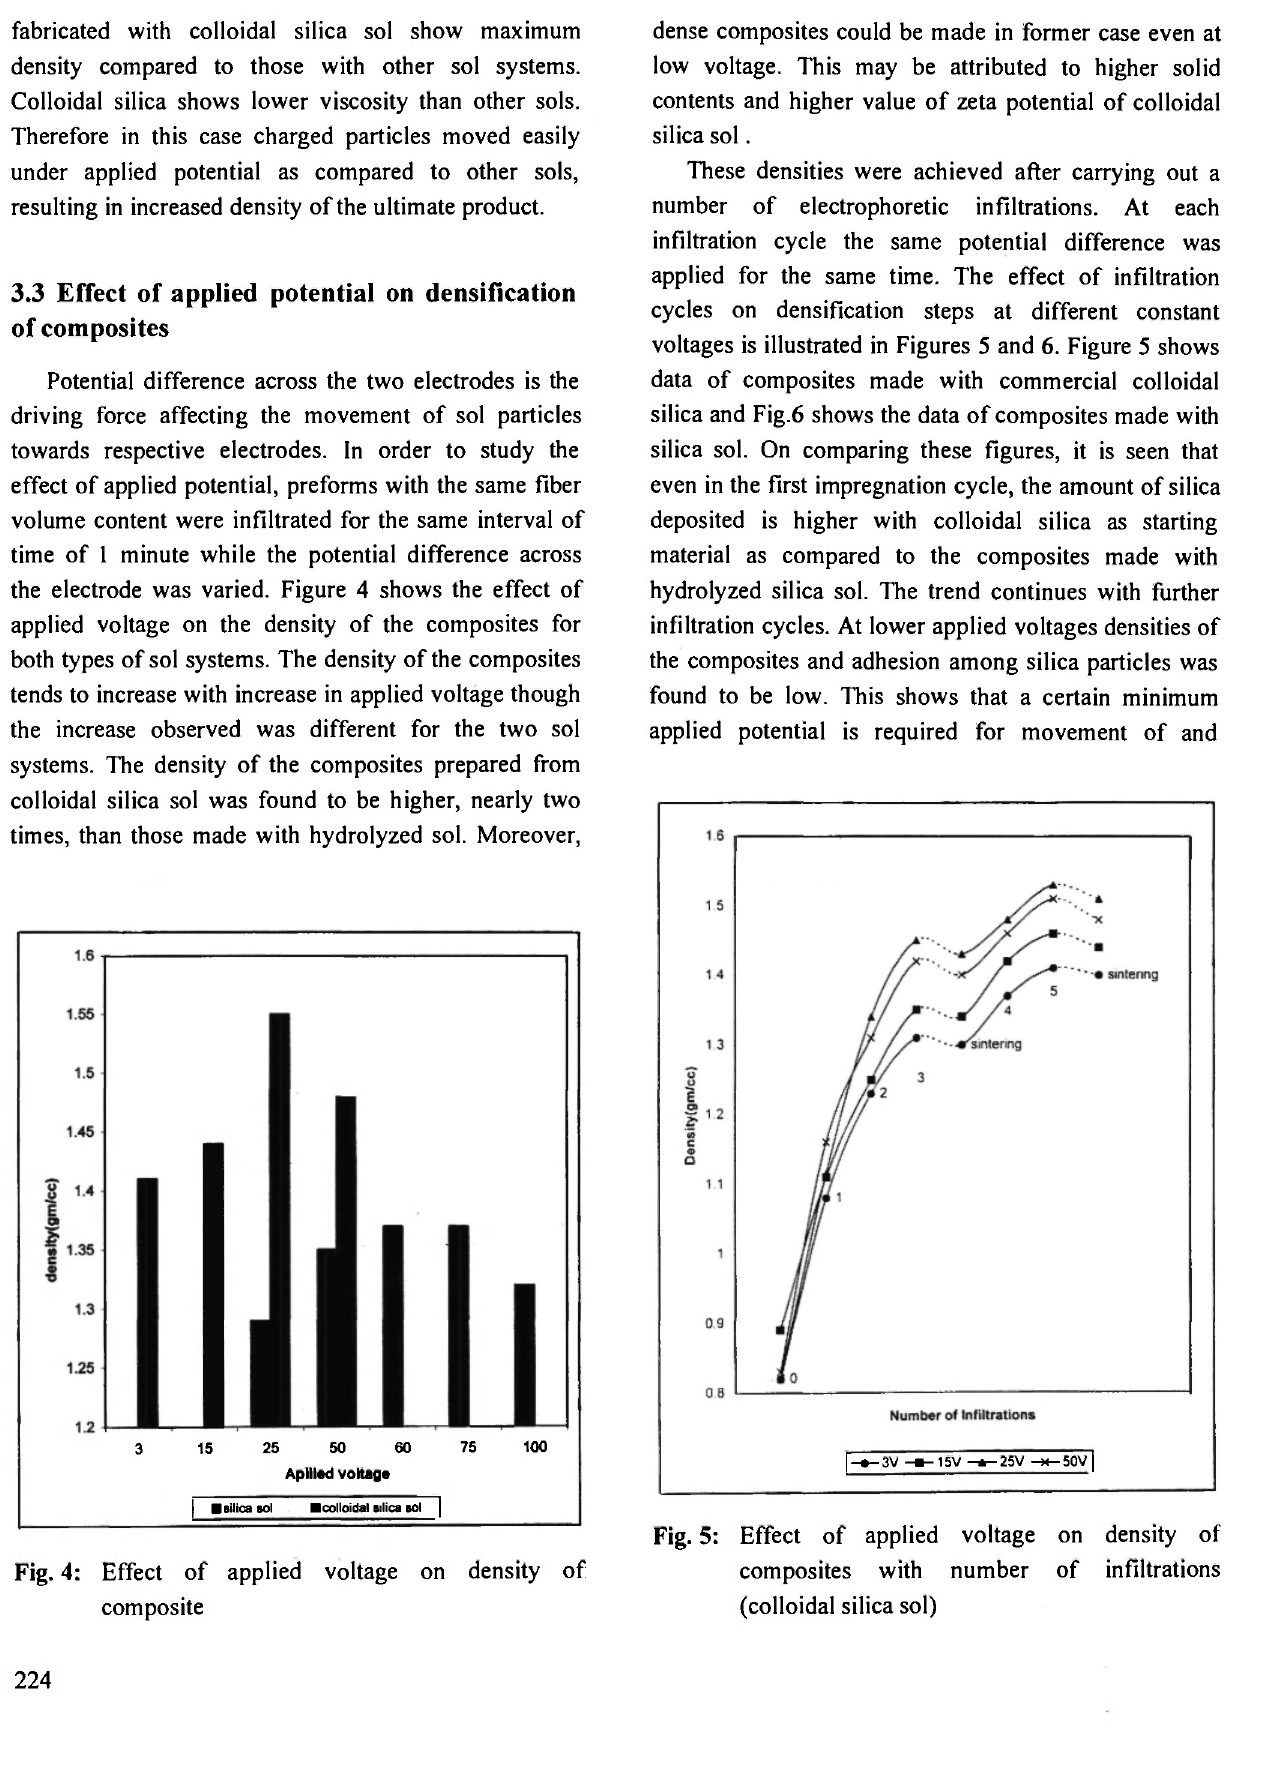
Fig. 5: Effect of applied voltage on density of composites